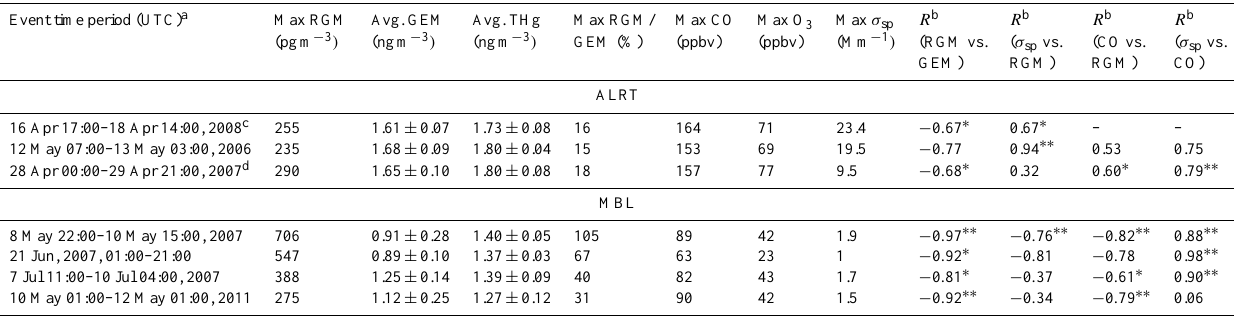
Table 1. Chemical characteristics of ALRT (type 2) and MBL (type 3) high-RGM events observed at MBO. Event time period (UTC) a